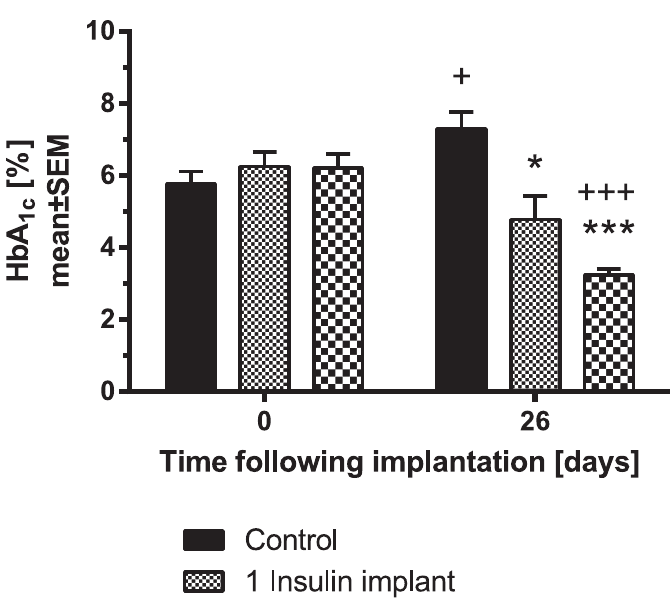
Fig 6. Blood HbA 1c in STZ-diabetic rats on day 0 and 26 days after implantation of insulin implants (1 or 2 implants/animal; n = 7 per group). * p < 0.05, *** p < 0.001 vs. control; + p < 0.05, +++ p < 0.001 vs. day 0.